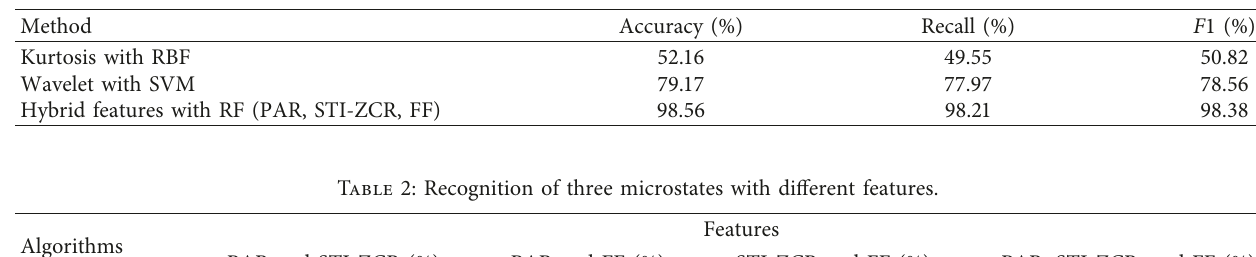
Figure 7: Hybrid feature distribution of four microstates. (a) Hybrid features of 0.2–0.1MPa. (b) Hybrid features of 0.3–0.2MPa. (c) Hybrid Table 1: Comprehensive comparison of hybrid features.